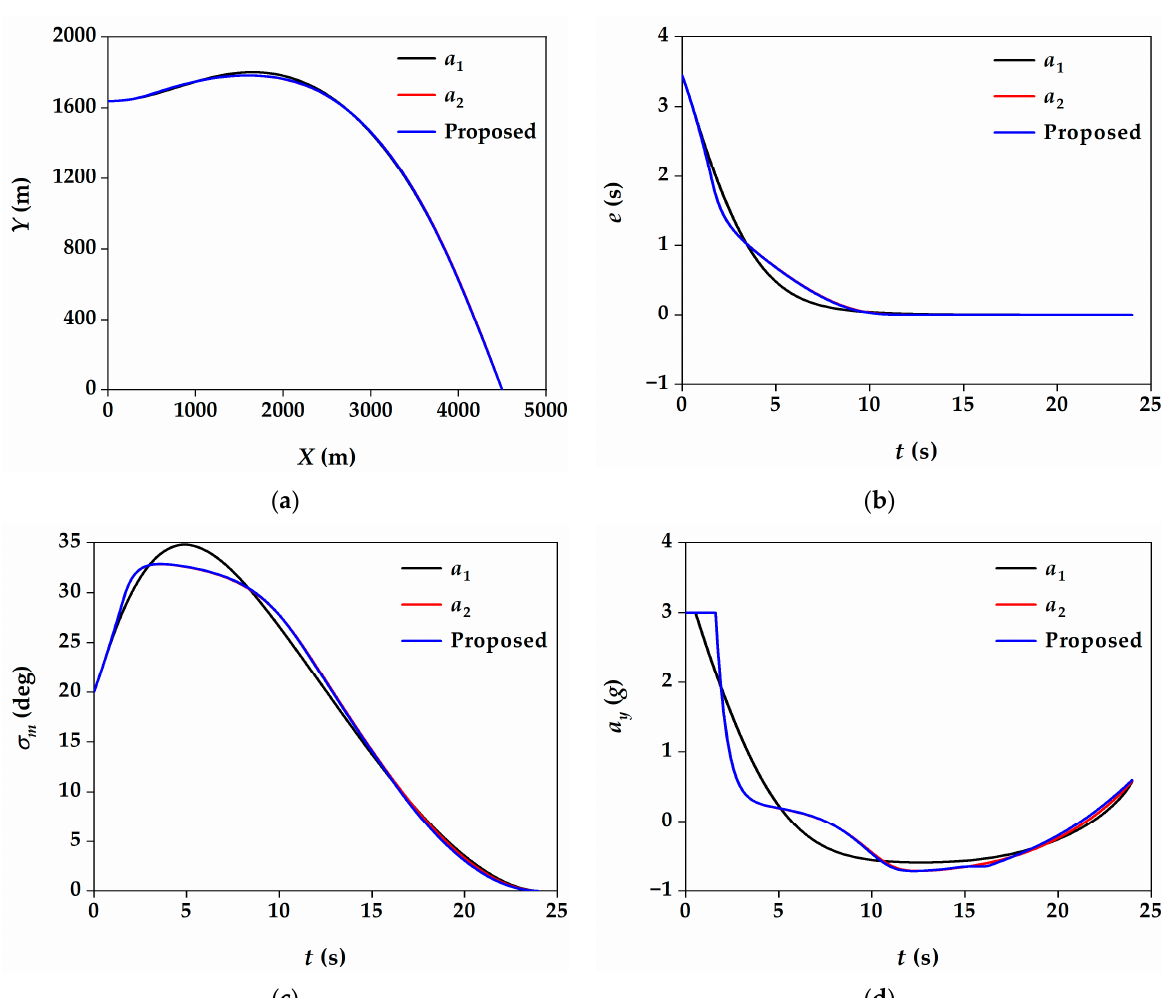
Figure 6. Comparison of simulation results under scenario 1. ( a ) Projectile flight trajectory; ( b ) impact time error; ( c ) lead angle; ( d ) normal acceleration.